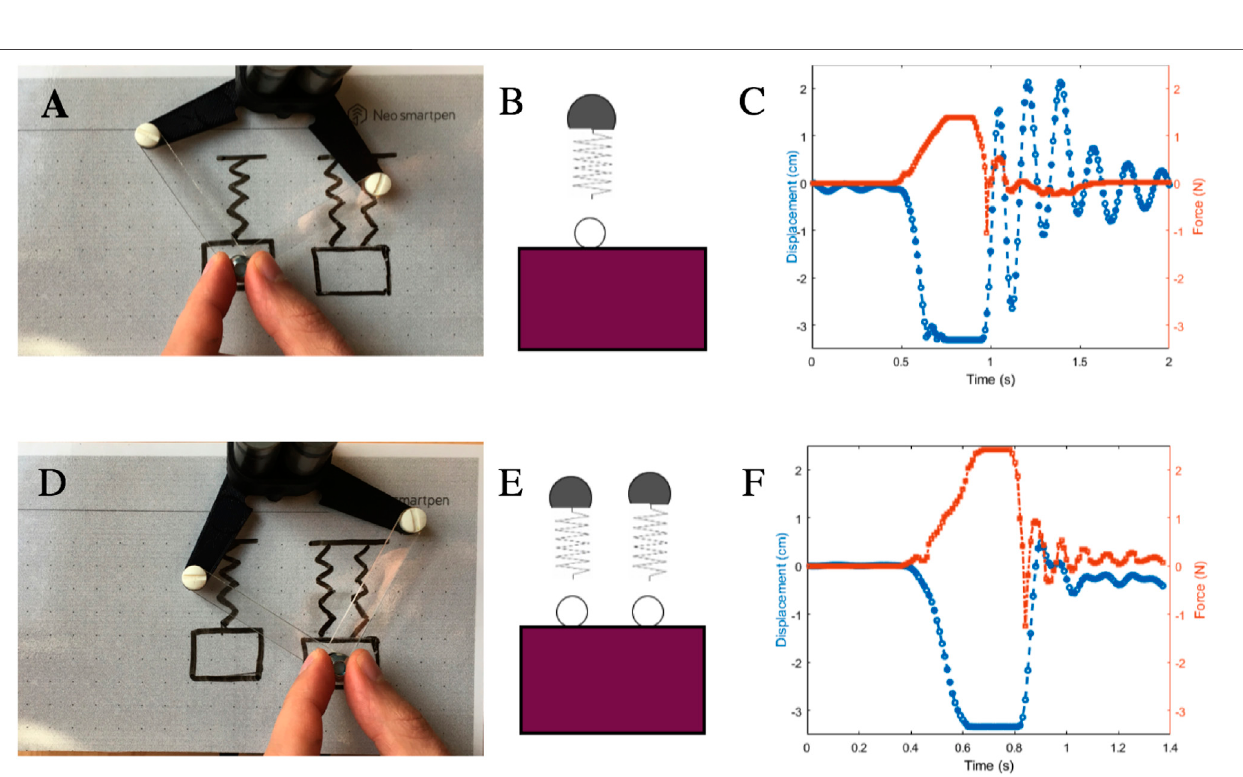
FIGURE 6 | Use case: comparing the dynamic behavior of different spring – mass system con fi gurations by drawing then feeling. (A) The user sketches a pair of spring – mass systems using a system-readable notation. (B,E) Our system recognizes the user ’ s strokes and incorporates them into virtual models. The user can now “ connect ” to one of the drawn masses by moving over it and e.g. , clicking a user interface button. (C) Behavior when connected to the single-spring con fi guration (A) . The system implements the corresponding model (B) by pinning X avatar to that mass. The user can then feel the oscillatory force behaviour by “ pulling the mass down ” , extending and releasing the spring. (D) The user connects to the two-parallel-springs con fi guration, and compares its behavior (model E) to the fi rst one. (F) compared to (C) shows a higher force for the same displacement, and a different oscillatory behavior. This system is implemented using a passivity controller to allow a wide range of M and K values, which are modi fi able by hand-writing new values on the sketch.